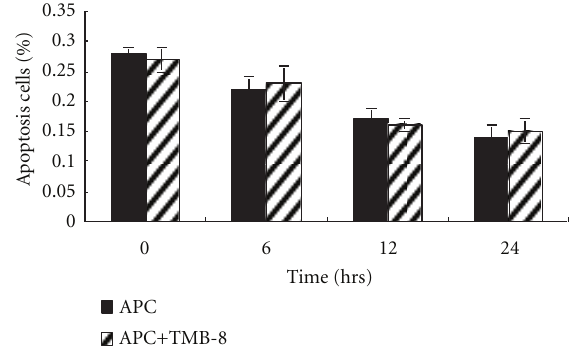
Figure 3: Calcium inhibition did not alter the antiapoptotic e ff ect of APC. After exposure to 10 ng/mL LPS for 24 h, HUVECs were treated with 150 nM APC for 0, 6, 12, and 24h in the presence or absence of 50 μ M TMB-8, an inhibitor of calcium release from the ER. There was no significant di ff erence in the percentage of apoptosis cells between the two groups, which was detected by flow cytometric analysis (APC versus APC + TMB-8, P > 0 .